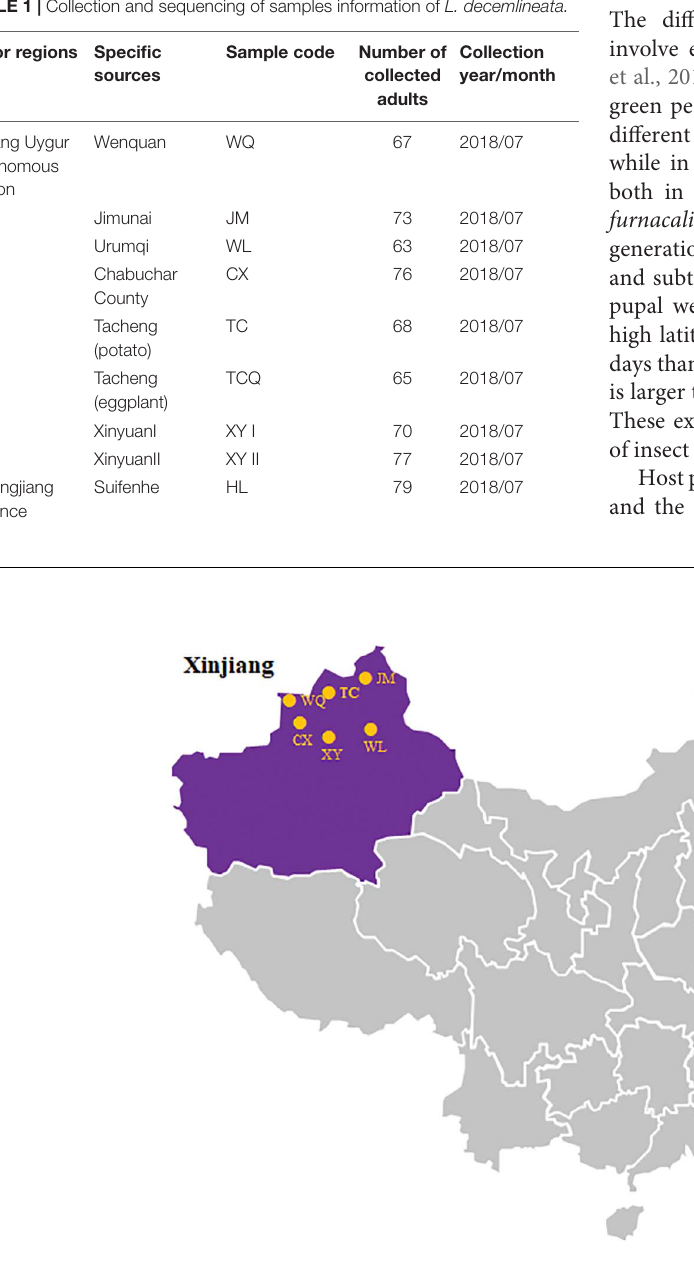
FIGURE 1 | Sampling sites of CPB. The sampling sites are shown in a map of China, and the two main collection areas are indicated by different colors.